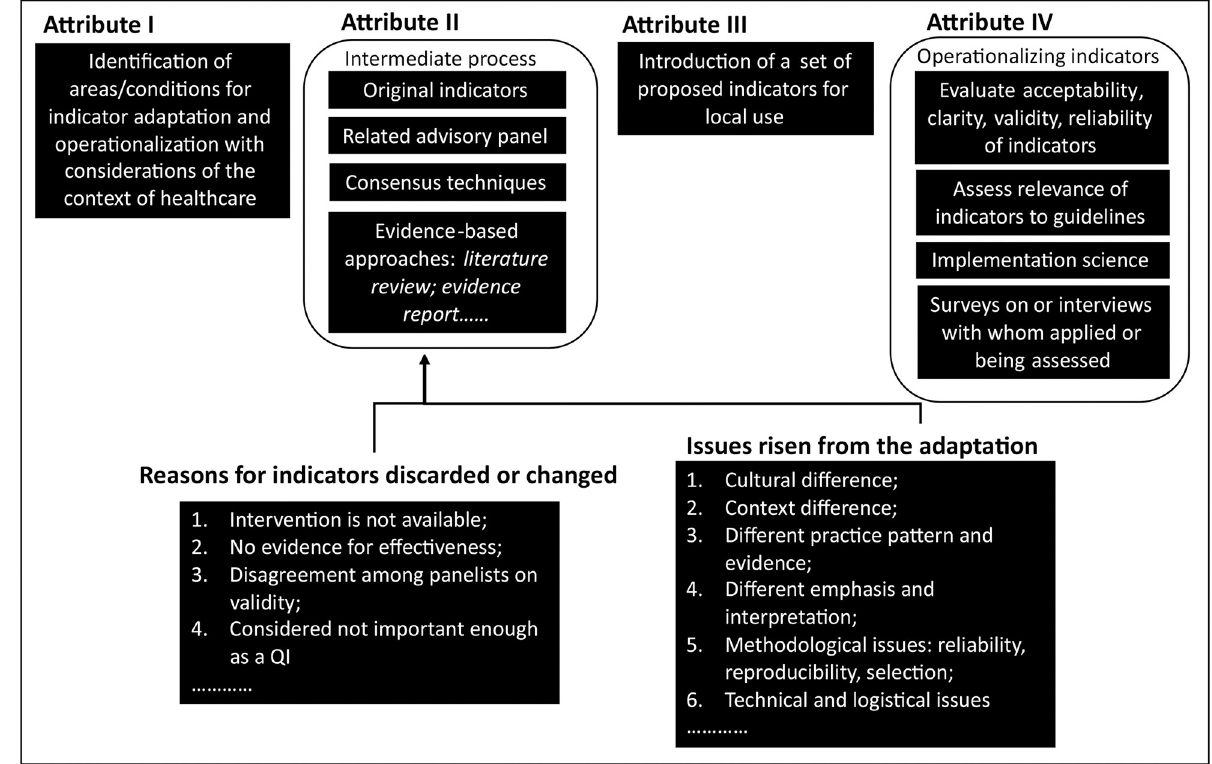
Fig 2. Map of attributes for adaptation